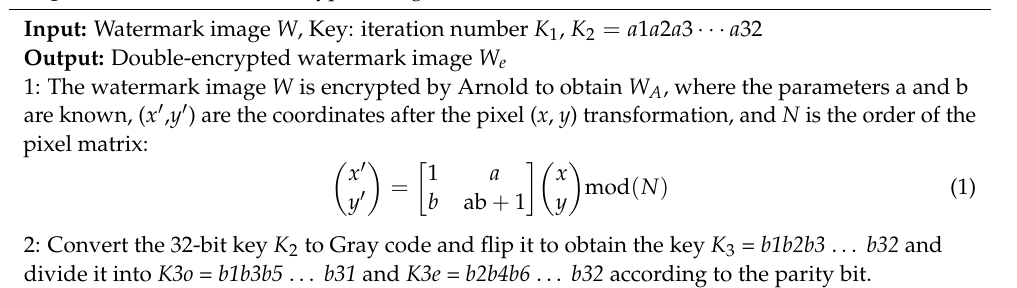
Algorithm 1: Two-Level Encryption